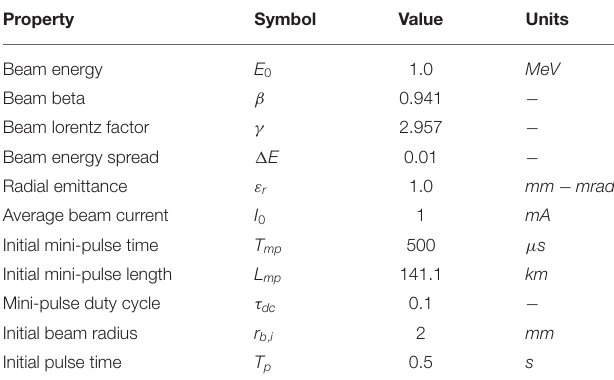
TABLE 1 | Physical parameters of the reference relativistic electron